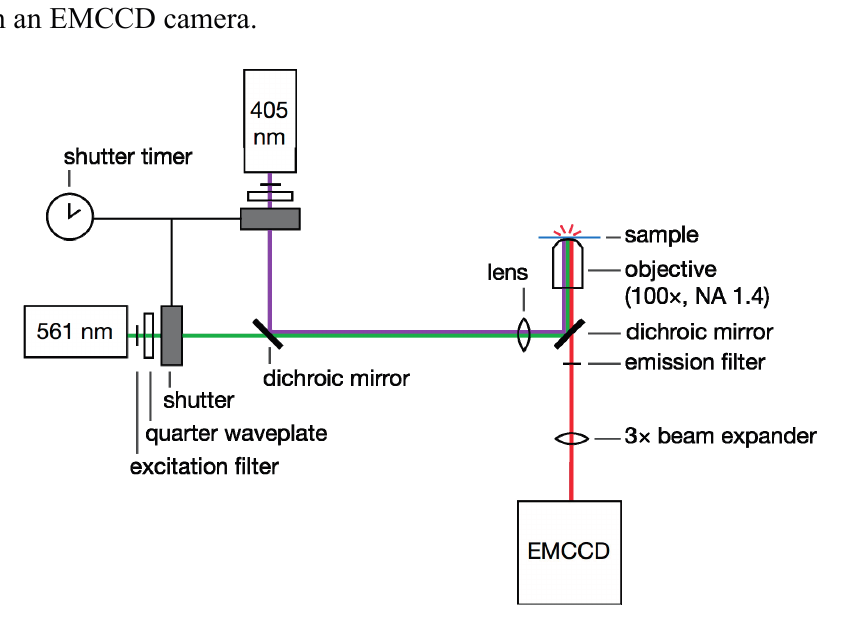
Figure 6. Single-molecule super-resolution imaging setup. 405- and 561-nm laser light is selected with excitation filters, circularly polarized with quarter waveplates, and controlled with a pair of shutters. The beams are coupled with a dichroic mirror. The laser beams are focused onto the back aperture of a high-NA microscope objective and the sample is excited by epi-illumination. Emitted fluorescence is filtered using an emission filter and a second dichroic. This emission is magnified with a beam expander if required and then detected on an EMCCD